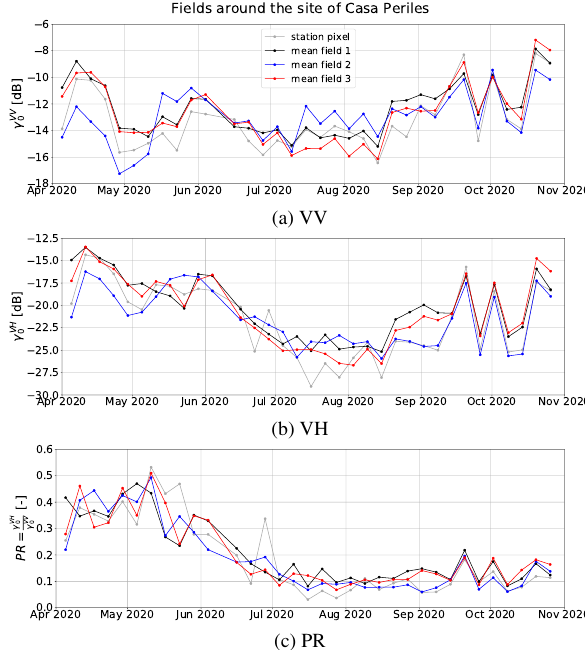
Figure 2. Time series of mean SAR parameters over three fields around the station of Casa Periles. The time series from April to October 2020 of γ V V 0 in dB, γ V H 0 in dB and PR are shown respectively in Figure 2a, 2b and 2c. In the graphs the grey line represents the pixel in which lays the measurement station, the black line illustrates the field 1, the blue line the field 2, and the red line the field